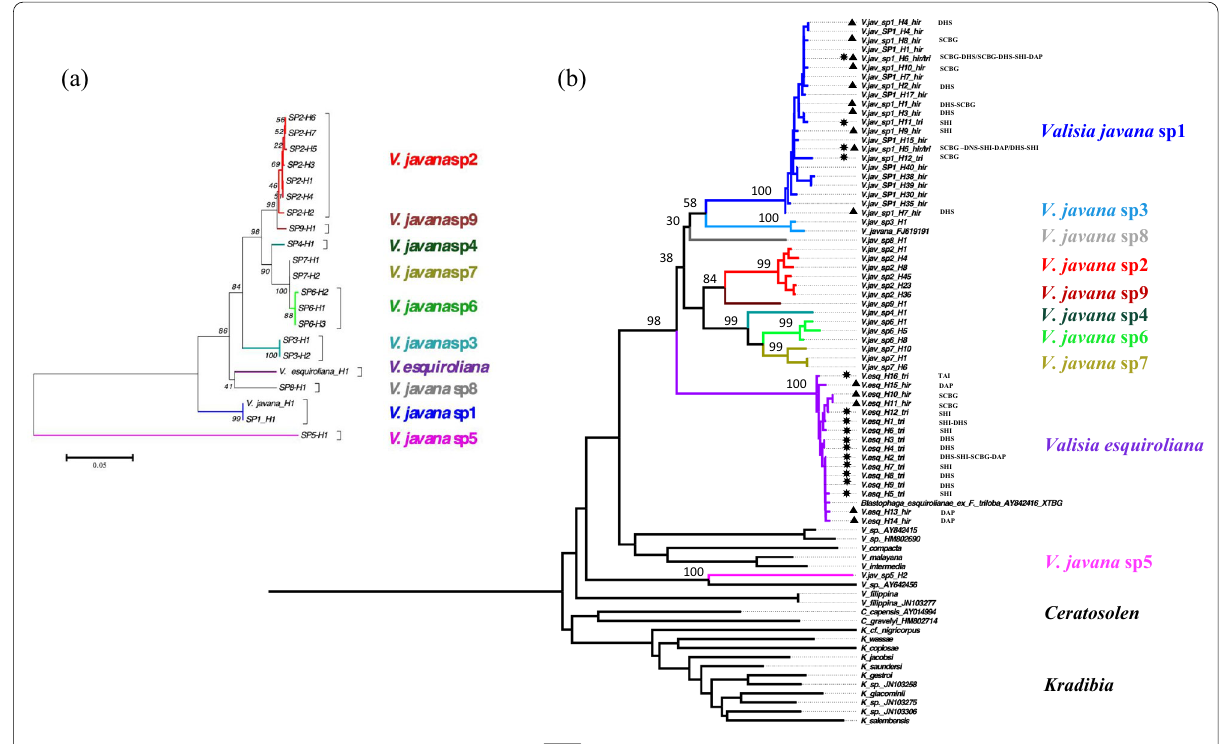
Fig. 4 a ITS2 neighbour joining tree of the Valisia fig wasp pollinators associated with Ficus hirta and Ficus triloba . b COI neighbour-joining tree of the pollinators associated, with sequences of Ceratosolen and Kradibia species as outgroups. Node support rates are shown. Haplotypes ( V. jav _ sp1_ H1 - H12 for Valisia javana complex sp 1 and V. esq _ H1 - H16 for V. esquirolianae ) are also listed together with their host figs ( hir triangles), tri F. triloba (black stars), hirt/tri both F. hirta and F. triloba ). The collecting sites of their hosts listed by haplotypes. For haplotypes of = = Valisia javana complex sp 1, those sequenced in this study is marked as sp 1 , the others extracted from Yu et al. (2019) are marked as